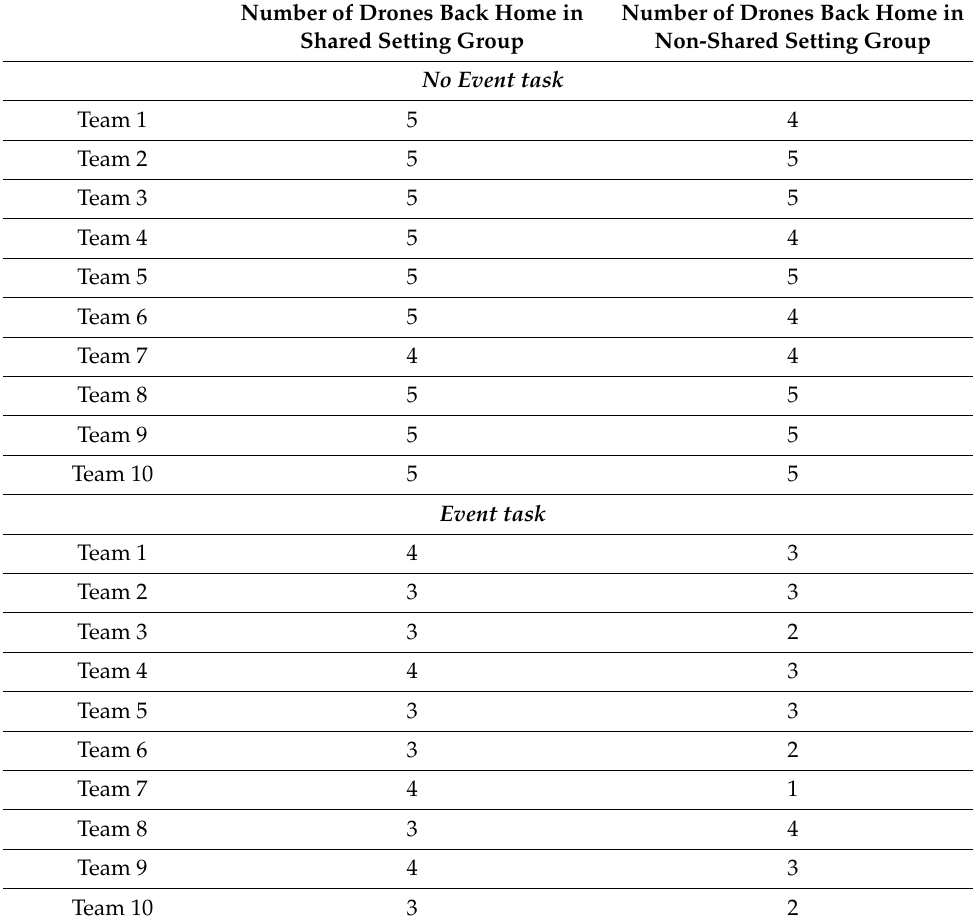
Table 4. The number of drones back home (DBH) at the end of each task. Number of Drones Back Home in Number of Drones Back Home in Shared Setting Group Non-Shared Setting Group No Event task Team